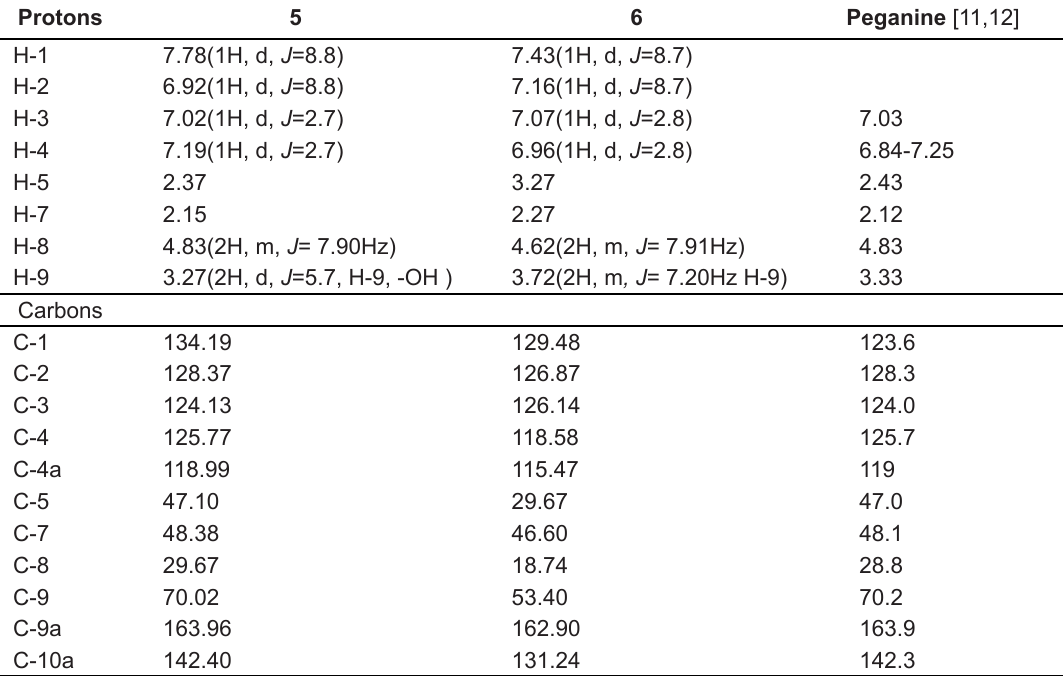
Table 2. 1 H and 13 C NMR chemical shift assignment for peganine ( 5 ) and deoxypeganine ( 6 ) (in CDCl